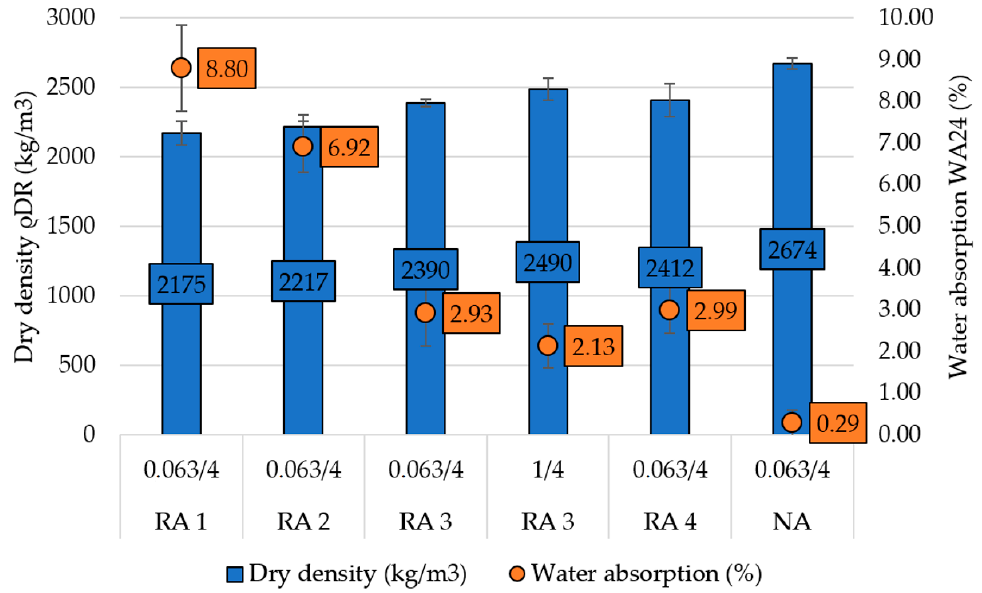
Figure 2. Oven-dry density and water absorption of aggregate according to CSN EN 1097-6.